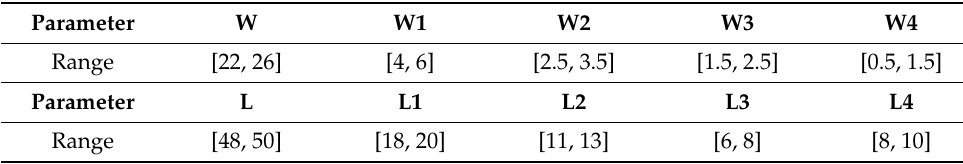
Figure 9. 3D view of the planar tri-band antenna in HFSSS: ( a ) front view of the antenna; ( b ) reverse view of the antenna. Table 3. Length range of the tri-band antenna sizes (unit: mm).